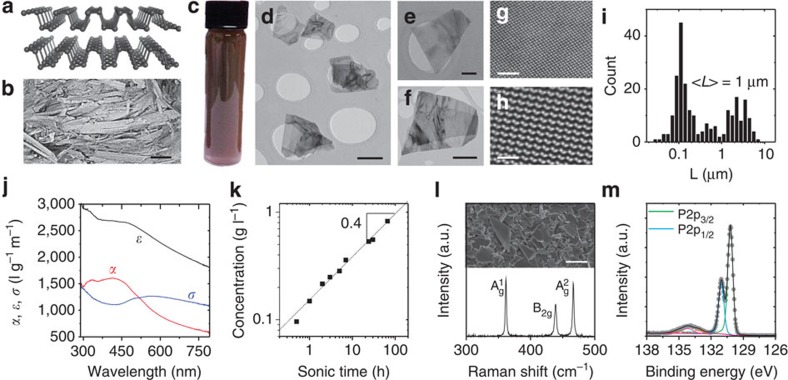
Basic characterization of exfoliated black phosphorous.(a) Structure of black phosphorus (BP). (b) SEM image of a layered BP crystal (scale bar, 100 μm). (c) Photograph of a dispersion of exfoliated FL-BP in CHP. (d–f) Representative low-resolution transmission electron microscopy (TEM) images of FL-BP exfoliated in N-cyclohexyl-2-pyrrolidone (CHP) (scale bars in d–f: 500, 100 and 500 nm). (g) Bright-field scanning transmission TEM (STEM) image and (h) Butterworth-filtered high-angle annular dark field (HAADF) STEM image of FL-BP (exfoliated in isopropanol) showing the intact lattice (scale bars in g and h, 2 and 1 nm). (i) Nanosheet length histogram of the exfoliated FL-BP obtained from TEM (sample size=239). (j) Extinction, absorbance, scattering coefficient spectra of FL-BP in CHP. (k) Concentration of FL-BP as a function of sonication time. The dashed line shows power law behaviour with exponent 0.4. (l) Raman spectrum (mean of 100 spectra, excitation 633 nm) of a filtered dispersion. Inset: scanning electron microscopic image of thin film (scale bar, 2 μm). (m) X-ray photoelectron spectroscopy P core-level region.